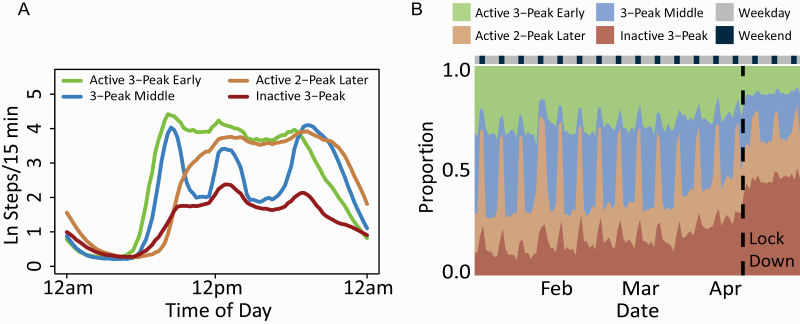
RAR profiles. (A) Centroids for the four key RAR profiles determined by k-means clustering of intraday step counts across 125,851 days from January to April 2020 from all participants for the “Active 3-Peak Early” (green curve, n = 28,723 days), “3-Peak Middle” (blue curve, n = 32,981 days), “Active 2-Peak Later” (brown curve, n = 30,635 days), and “Inactive 3-Peak” (red curve, n = 33,512 days) clusters. Clusters were differentiated by timing of morning rise and evening drop as well as magnitude of steps across the 24 h day. (B) Proportion of time spent in the four RAR profiles from January to April 2020. Pre-lockdown, weekday rhythms primarily consisted of the “Active 3-Peak Early” and “3-Peak Middle” profiles, while weekend rhythms mainly consisted of the “Active 2-Peak Later” and “Inactive 3-Peak” profiles. During the lockdown, a clear increase in the proportion of time spent in the “Active2-Peak Later” and “Inactive 3-Peak” profiles was observed, together with an attenuation of weekday–weekend rhythms.